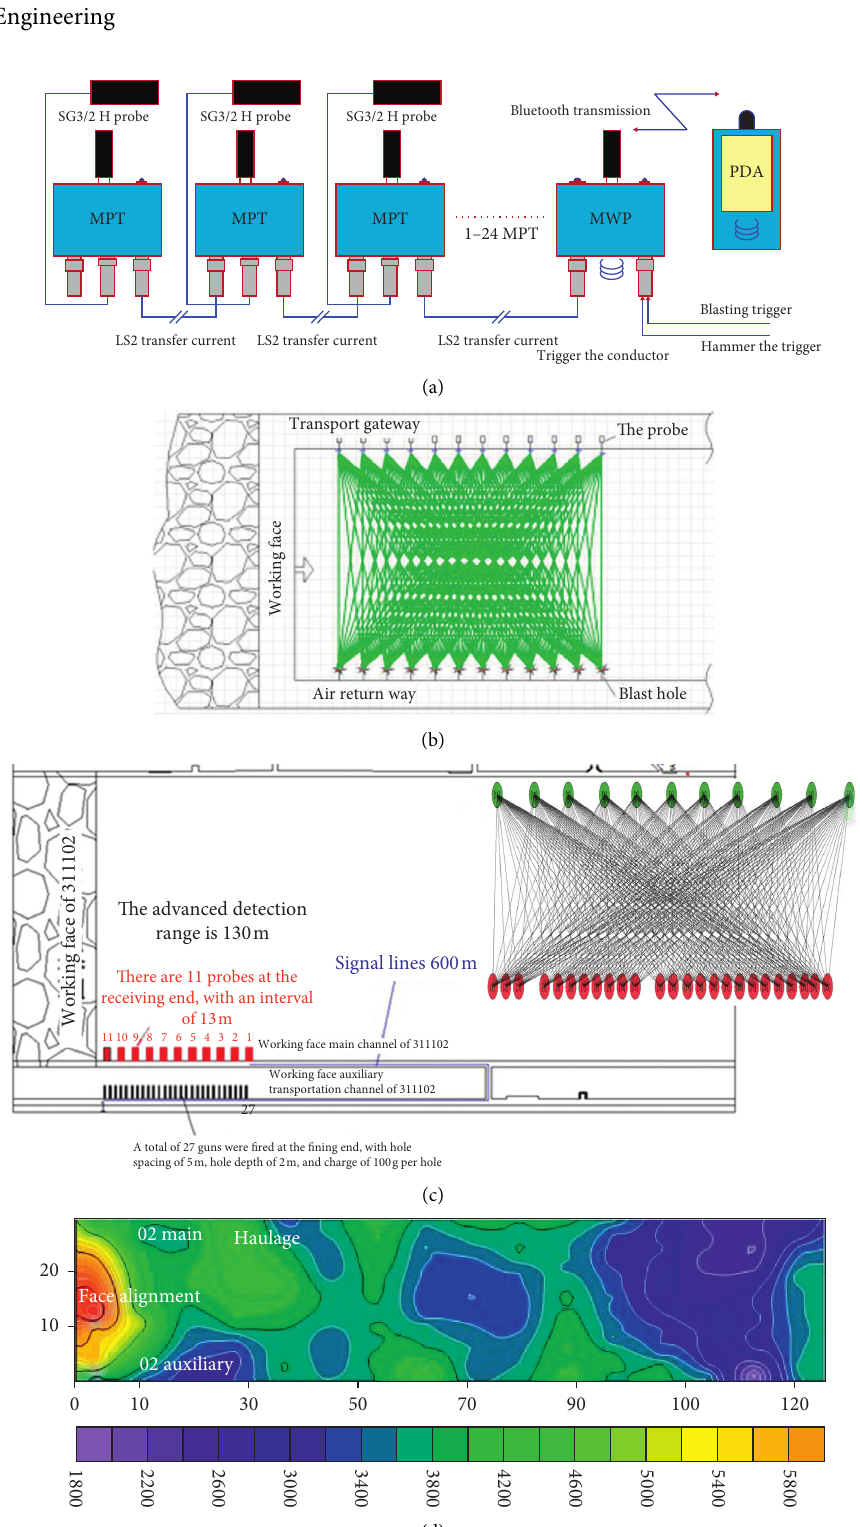
Figure 5: PASAT-MPortable microseismic detection system and coal pillar stress field. (a) Seismic CT technical schematic diagram of the coal mining face. (b) Seismic CTtechnical schematic diagram of the coal mining face. (c) 311102 working face pillar of the coal PASAT—M monitoring programme. (d) 311102 coal pillar wave velocity field between main transport and auxiliary transport on the working